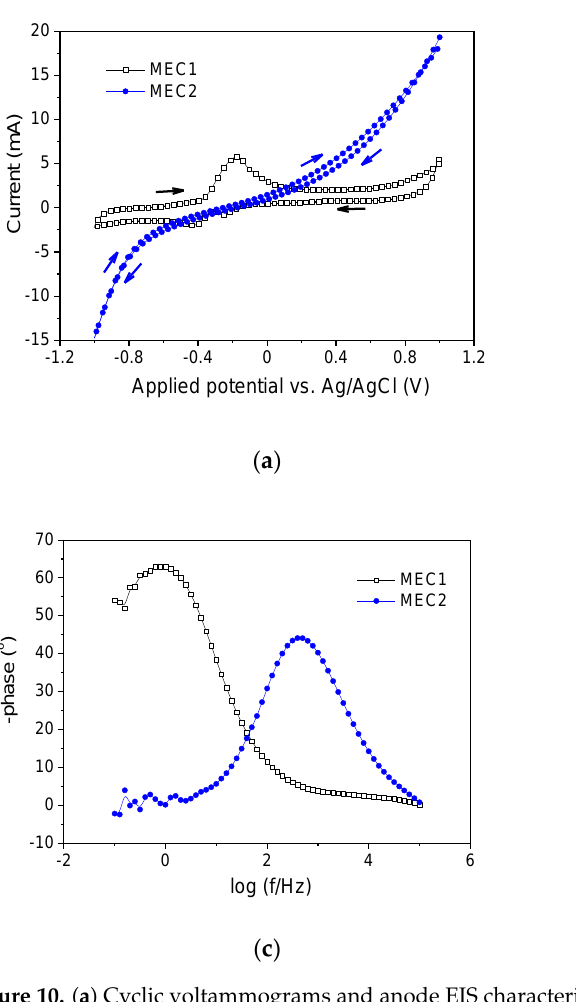
Figure 10. ( a ) Cyclic voltammograms and anode EIS characteristics for MEC1 and MEC2 at 0.9 V vs. Ag/AgCl, depicted in the form of ( b ) Nyquist plots, ( c ) phase angle vs. log (frequency) Bode plots and ( d ) admittance plots. Measurements were conducted in a three electrode set-up (anode as working electrode (WE), cathode as a counter electrode (CE) and Ag/AgCl electrode, immersed in the anolyte, as reference electrode (RE)). An acetate based wastewater was used as substrate in both MECs. Open circuit anode voltages (vs. Ag/AgCl): −0.15 V for MEC1 and −0.2 V for MEC2.